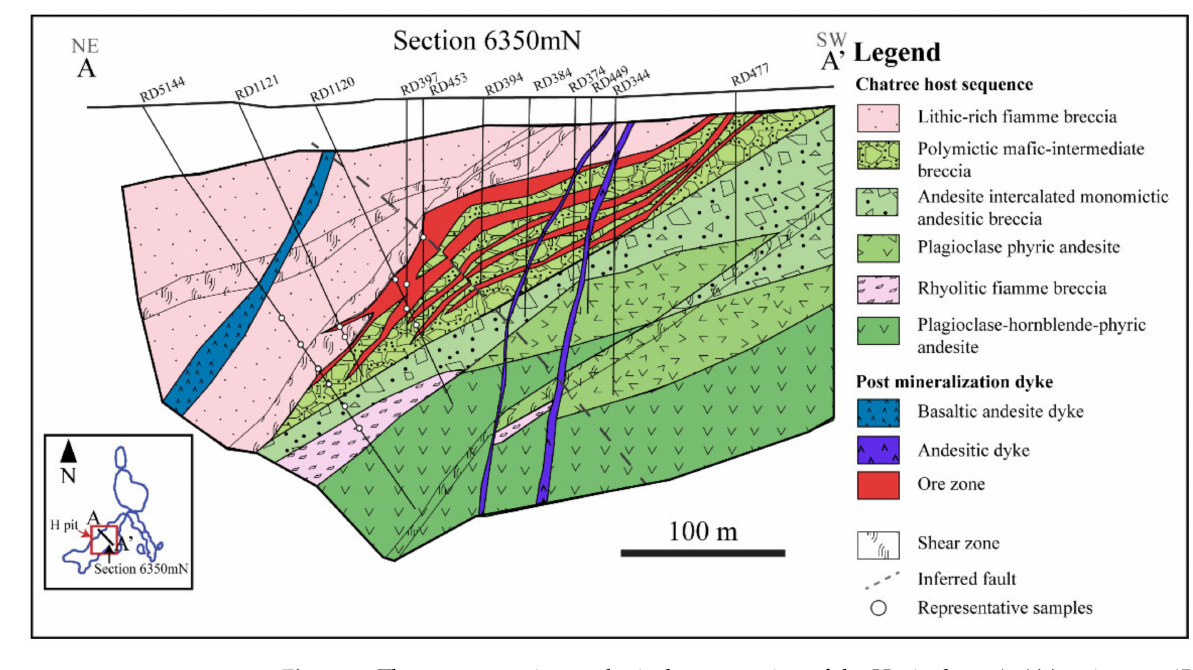
Figure 2. The representative geological cross section of the H-pit along A-A’ (section no. 6530 mN) showing all rock types of the host sequence and ore zone. Note that the ore zone and rocks of the host rock sequence are often cross-cut by post-mineralization basaltic andesite and andesite dykes. Data modified after [30]. Table 1. Summary description and mineral content of the samples from the H ore lens of the Chatree